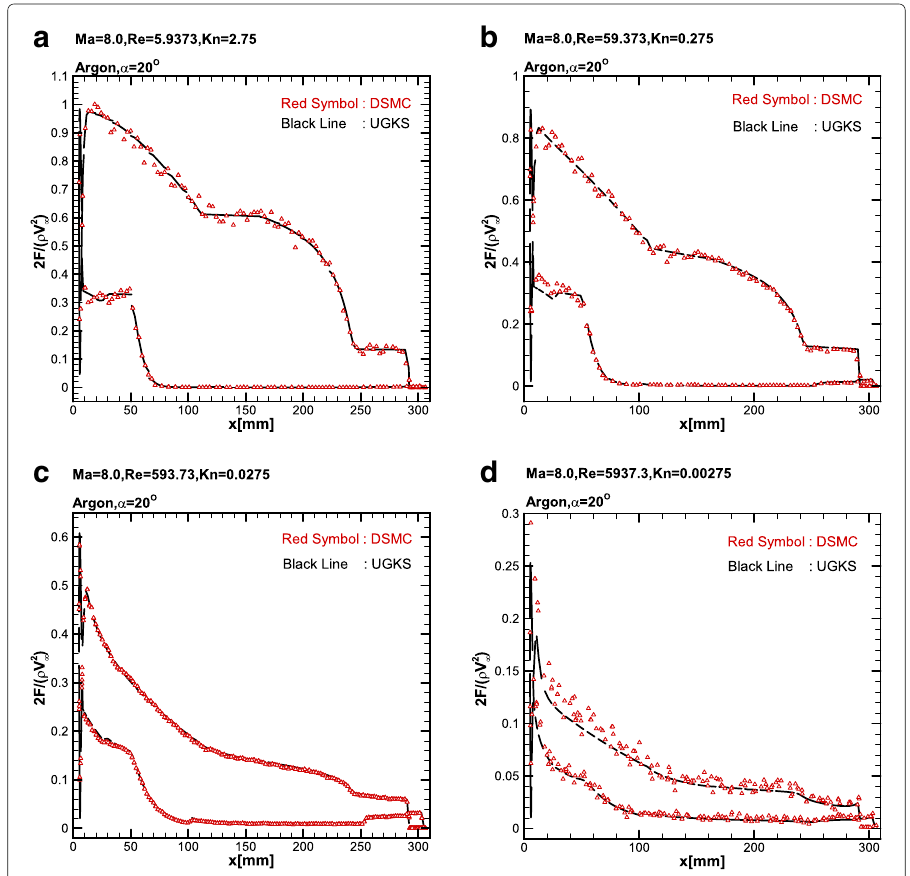
Fig. 7 Comparison of surface friction distributions. Red symbol: DSMC; Black line: UGKS